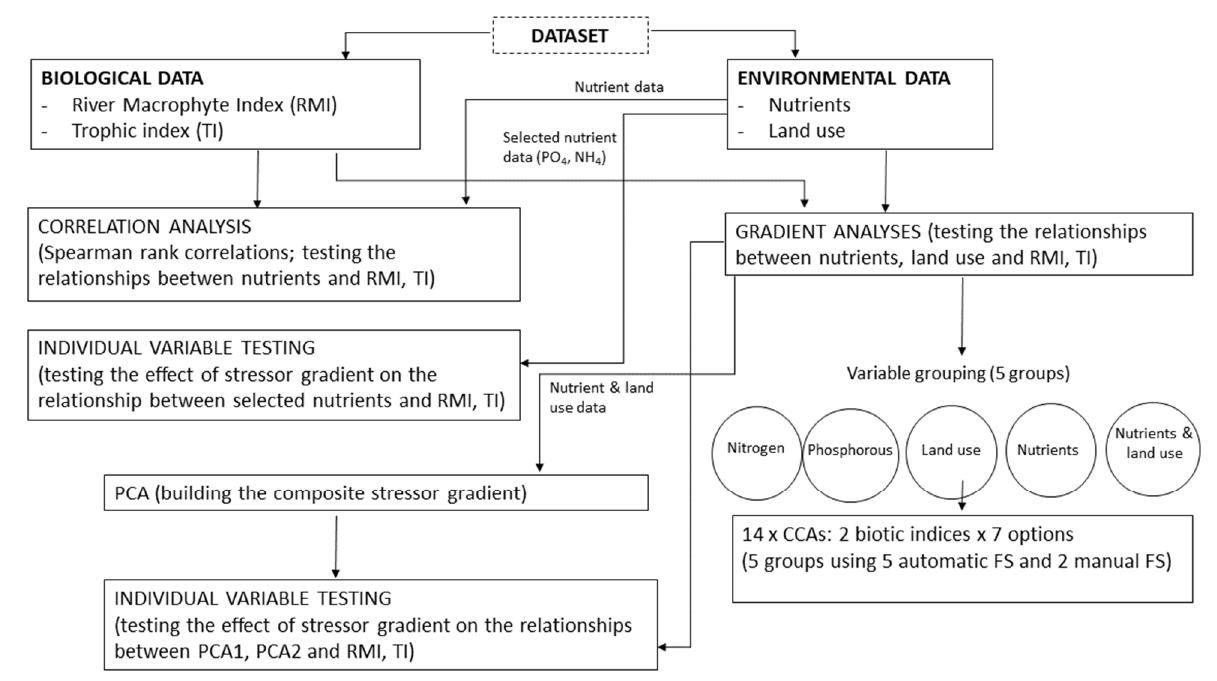
Figure 2. Flowchart of the analytical procedure. CCA: Canonical Correspondence Analyses, FS: Forward selection, and PCA: Principal Component Analysis.